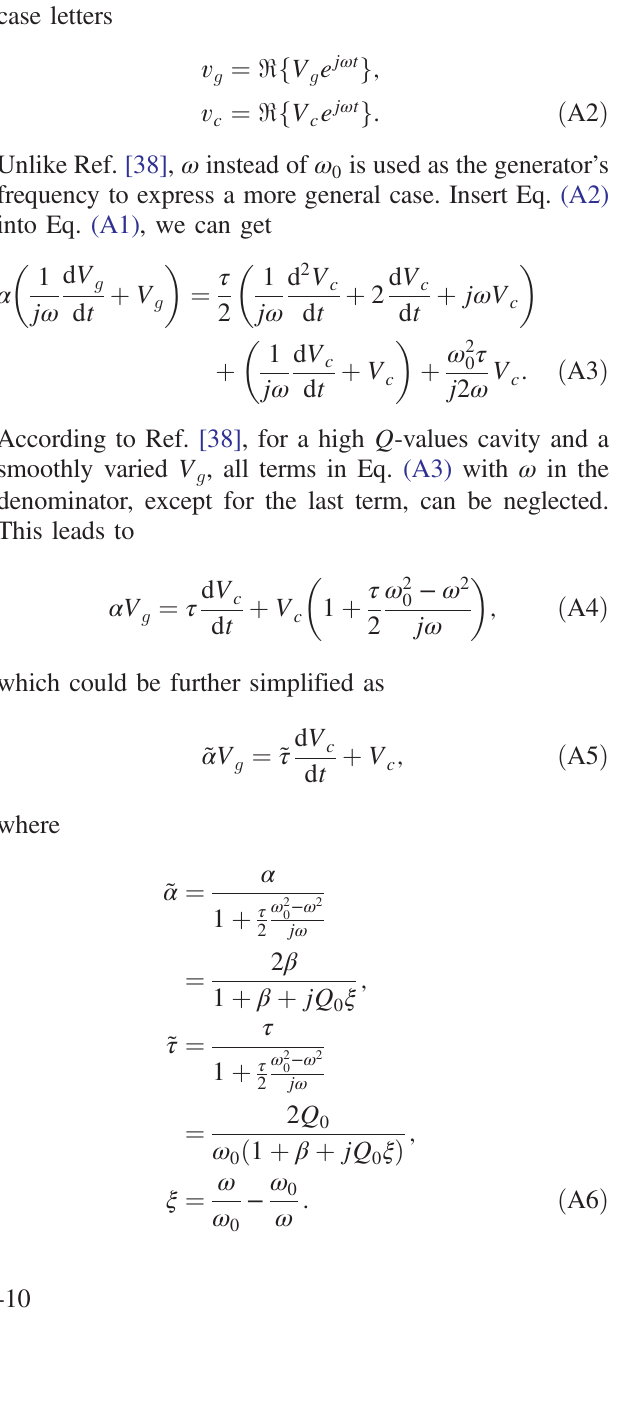
FIG. 17. Phase information of the one-stage pulse